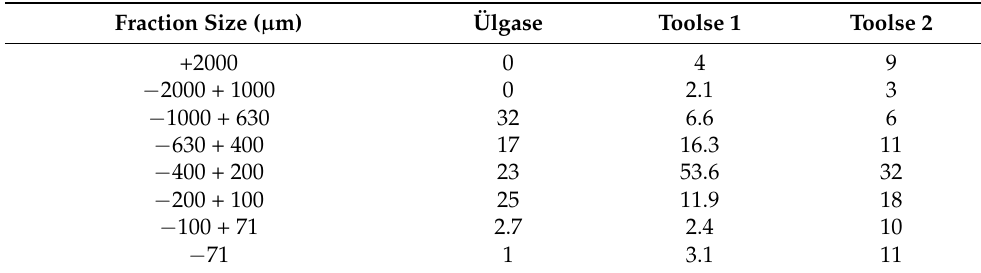
Table 2. Fractional composition of Estonian PR samples (as received),